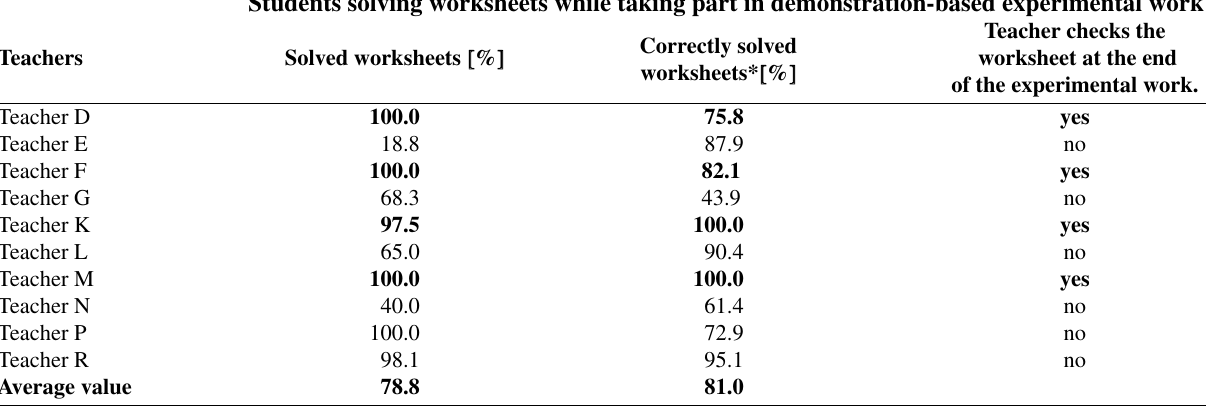
Table 3: Analysis of collected data when evaluating the worksheets, the students used during students’hands-on experimental work. Students solving worksheets while taking part in demonstration-based experimental